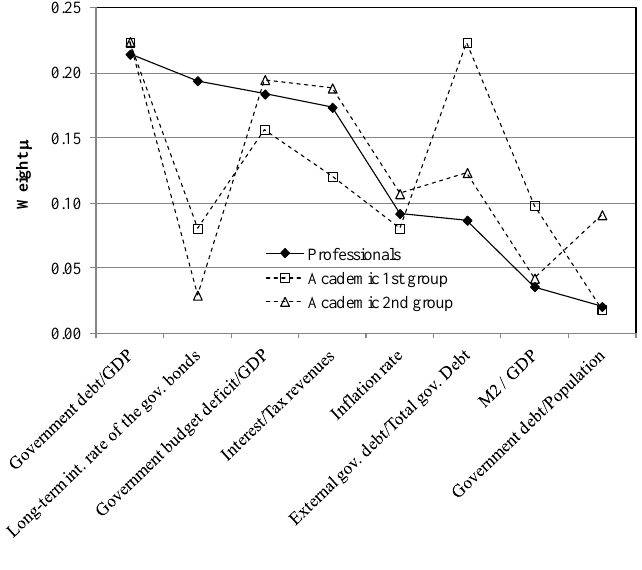
Fig. 1. Parameter weights by expert